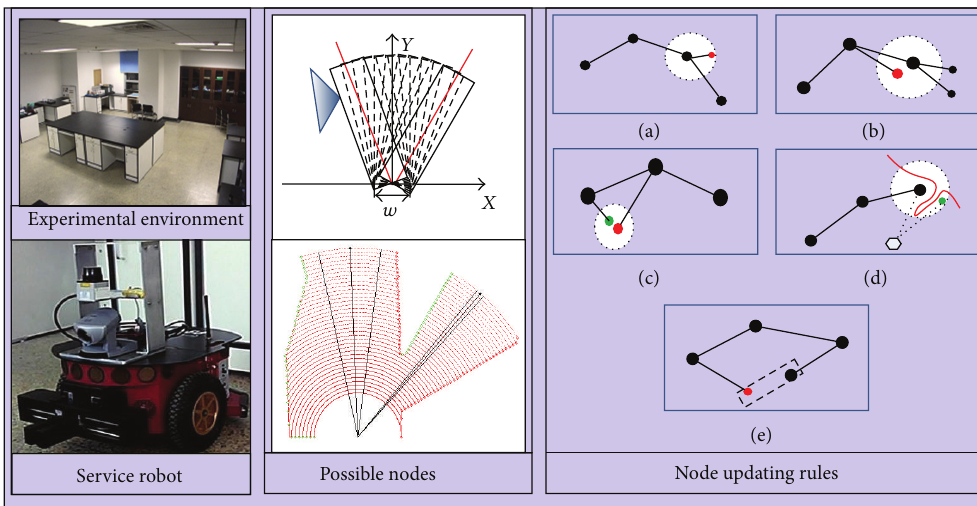
Figure 3: Possible nodes abstraction